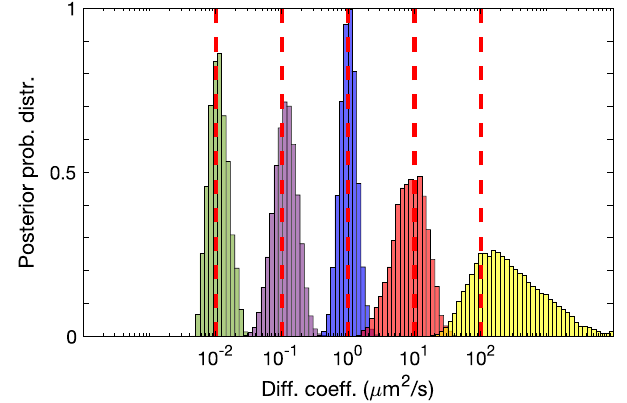
FIG. 6. A lower diffusion coefficient provides more photons per unit time and sharper diffusion-coefficient estimates. Pos- terior probability distributions drawn from traces contain- ing ≈ 2000 photon arrivals produced by four molecules diffusing at D ¼ 0 . 01 ; 0 . 1 ; 1 ; 10 μ m 2 = s for a total time of 30 ms under background and molecule photon emission rates of 10 3 photons = s and 4 × 10 4 photons = s, respectively. For mol- ecules diffusing at D ¼ 100 μ m 2 = s, under similar conditions, we use a trace containing ≈ 3000 photons for a total time of 50 ms, since we needed a longer trace to gather sufficient information for drawing a posterior.